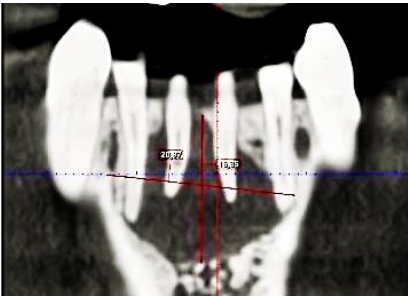
Figure 2. A frontal image of the CBCT taken on the first appointment showing bone resorption (with a diameter of 20.97 mm width and 16.35 mm height) of the cyst in the middle of the lower jaw.